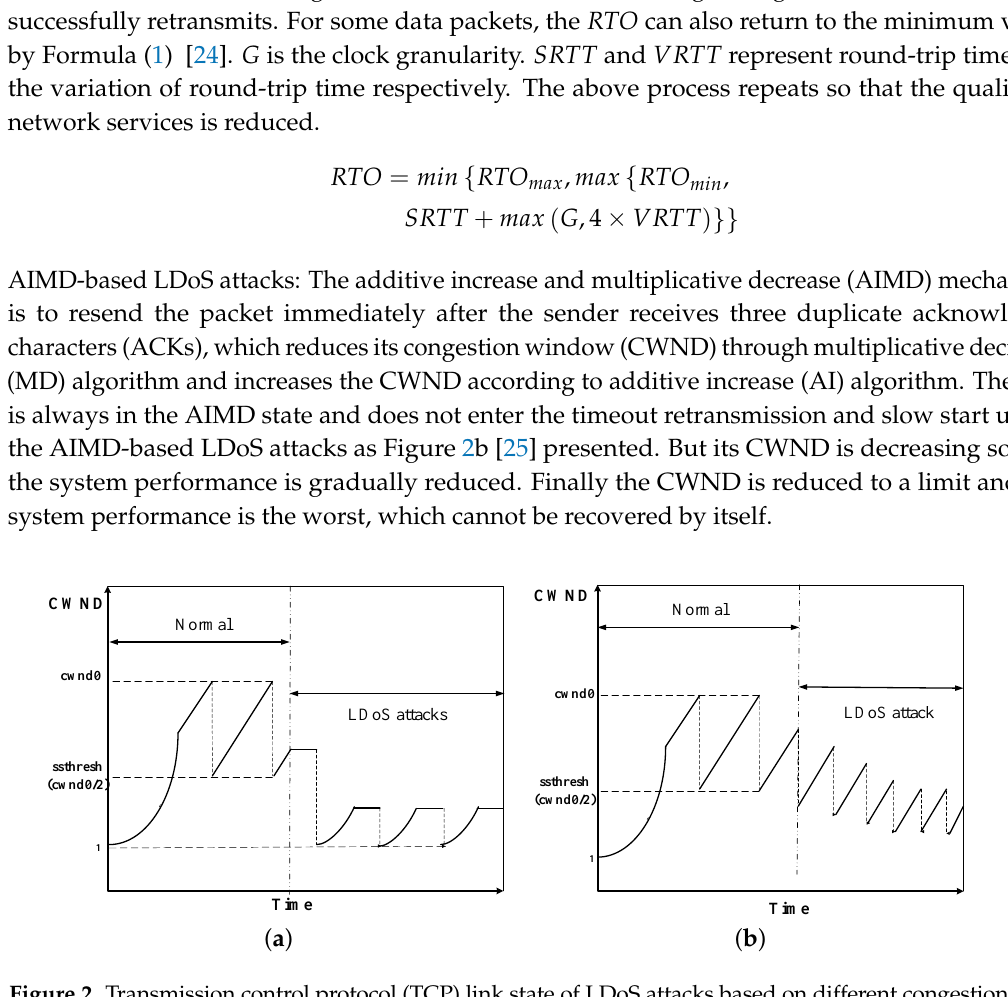
Figure 2. Transmission control protocol (TCP) link state of LDoS attacks based on different congestion control mechanisms: ( a ) shows congestion window (CWND) under retransmission timeout (RTO)-based LDoS attacks, ( b ) depicts CWND under additive increase multiplicative decrease (AIMD)-based LDoS